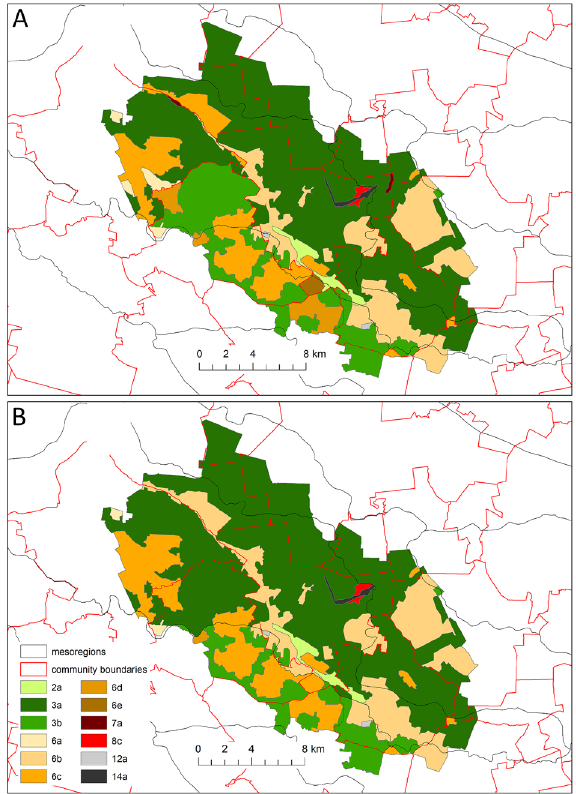
Fig. 5. Local landscapes distinguished by a modified method (A) and audit method (b). Explanation of landscape subtypes in Table 1.